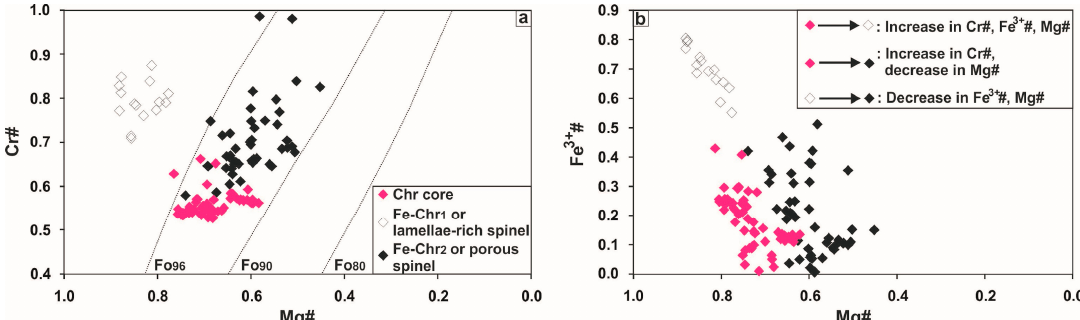
Figure 11. Variations of altered Cr-spinel in terms of: ( a ) Cr# vs. Mg#; ( b ) Fe 3+ # vs. Mg#. The composition of Cr-spinel is contoured at a nominal T of 1200 °C for olivine compositions from Fo 80 to Fo 96 [43]. Abbreviations as in Figure 5.